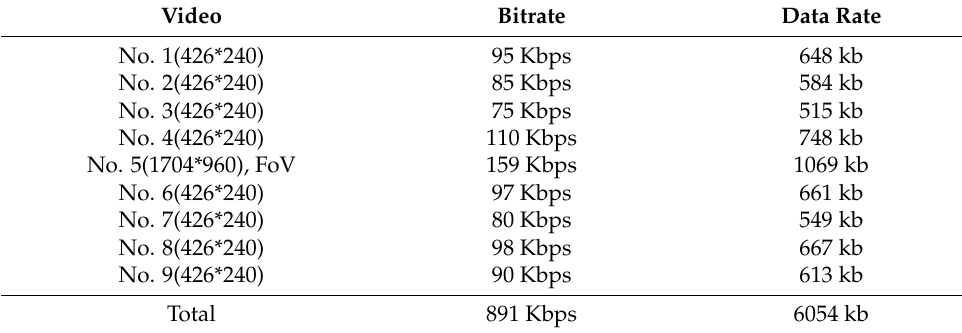
Table 7. Bitrate and size comparison for each streaming video